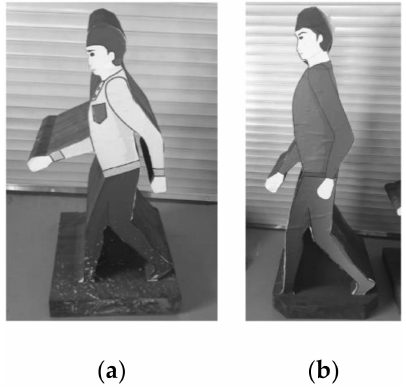
Figure 9. Dummy ( a ) Child Dummy ( b ) Adult Dummy.